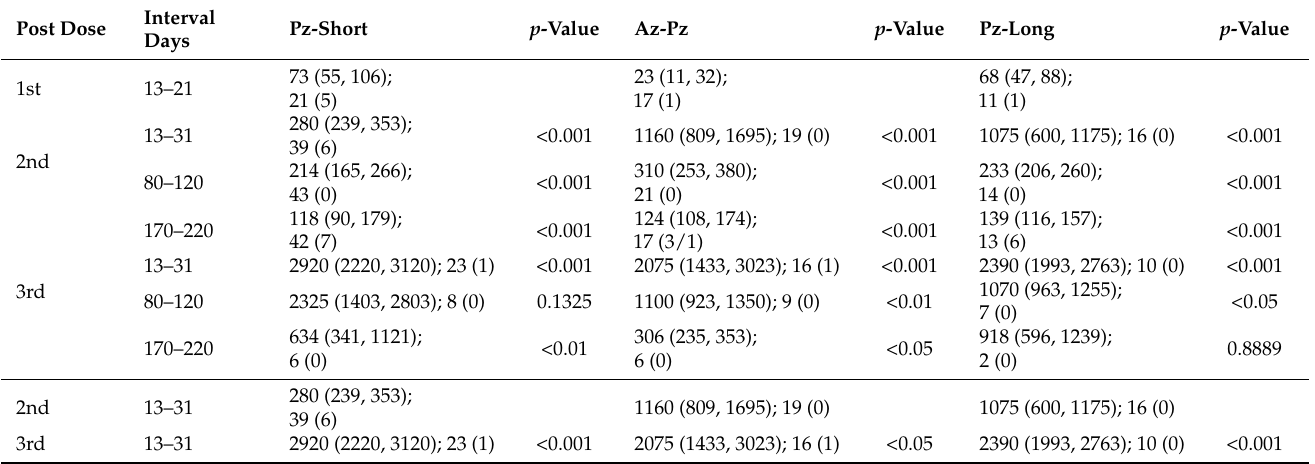
<0.001 1075 (600, 1175); 16